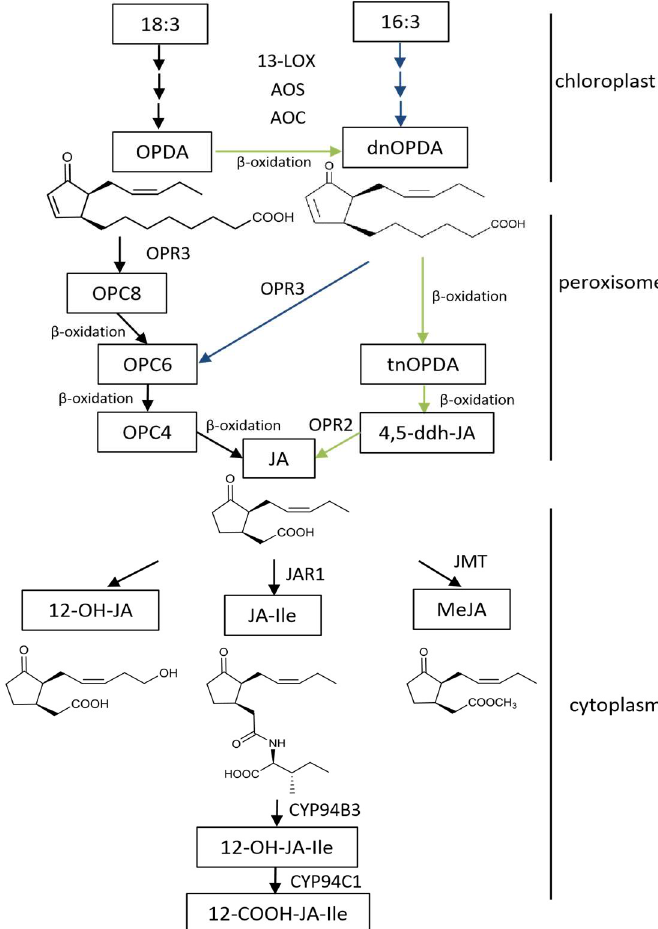
Figure 1. Scheme of the JAs biosynthesis pathway in Arabidopsis thaliana . The enzymes and the intermediates are indicated as follows: LOX for lipoxygenase, AOS for allene oxide synthase, AOC for allene oxide cyclase, OPR3 for OPDA reductase, JAR1 for jasmonate resistant 1, JMT for JA carboxyl methyltransferase; 18:3 for α-linolenic acid, 16:3 for hexadecatrienoic acid, OPDA for 12-oxo-phytodienoic acid, dnOPDA for dinor-12-oxo-phytodienoic acid, OPC8 for 8-(3-oxo-2-(pent-2-enyl)cyclopentyl) octanoic acid, OPC6 for 6-(3-oxo-2-(pent-2-enyl)cyclopentyl) hexanoic acid, OPC4 for 4-(3-oxo-2-(pent-2-enyl)cyclopentyl) butanoic acid, tnOPDA for tetranor-OPDA, 4,5-ddh-JA for 4,5-didehydrjasmonate, JA for jasmonic acid, JA-Ile for jasmonoyl-L-isoleucine, and MeJA for methyl jasmonate.